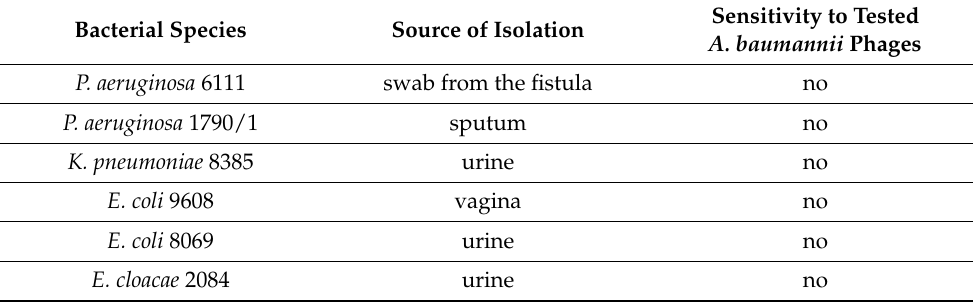
Table 1. Characteristics of Gram-negative bacterial strains other than Acinetobacter spp. Bacterial